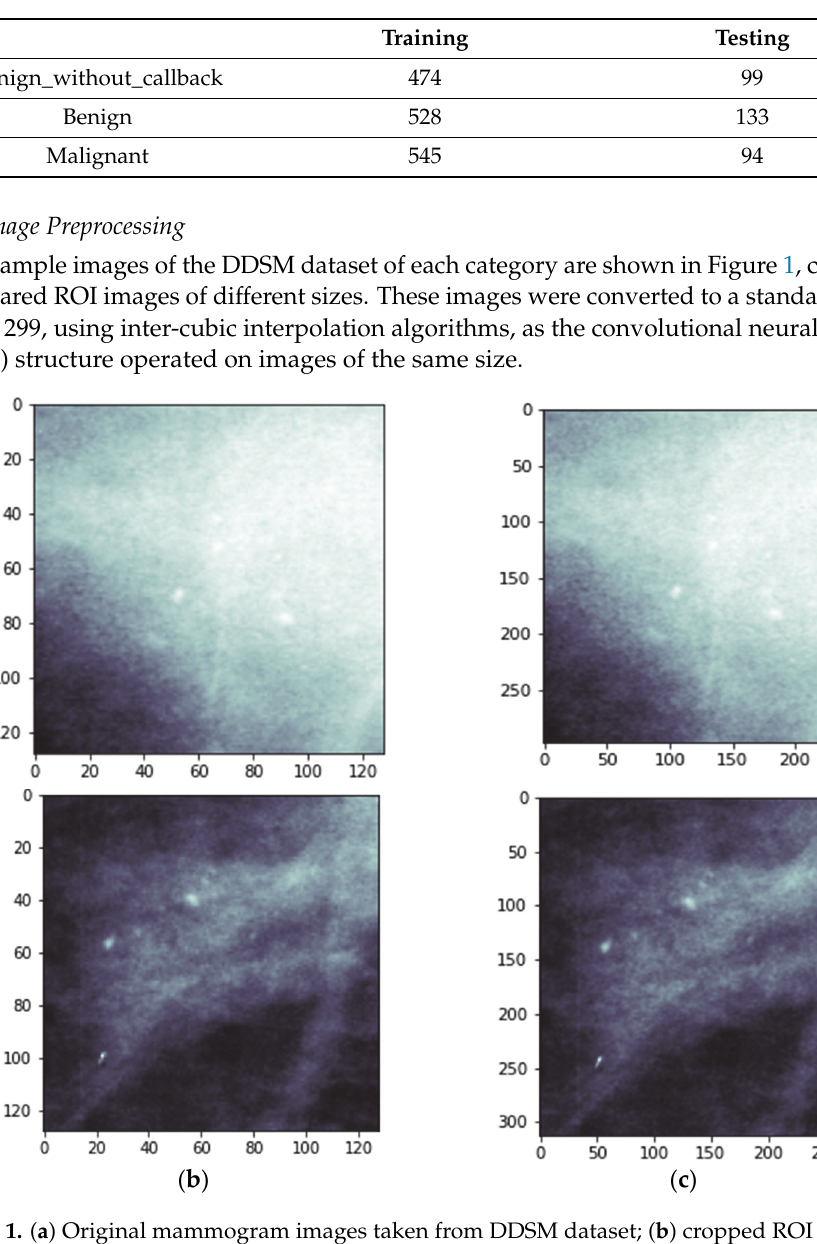
Table 1. The number of images used in each class.